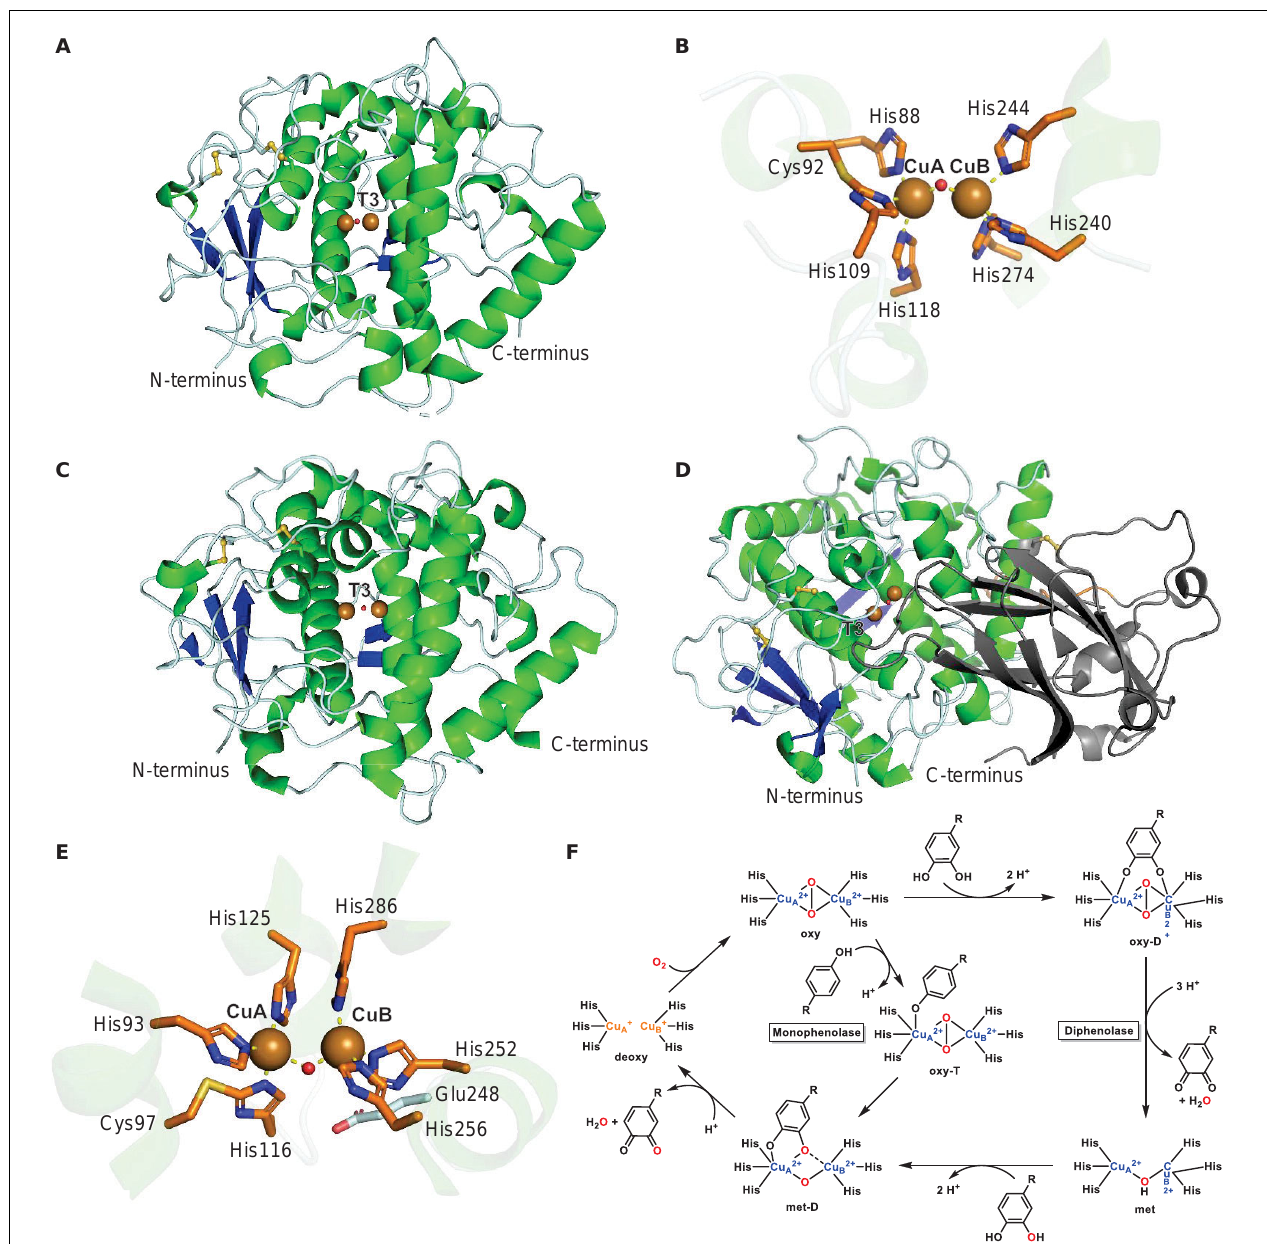
FIGURE 4 | Structures and mechanism of plant type III polyphenol oxidases. (A) Protein structure of active form of sweet potato catechol oxidase Ip CO (PDB: 1BT1) (Klabunde et al., 1998). (B) T3 copper center of sweet potato catechol oxidase Ip CO. (C) Protein structure of active walnut tyrosinase Jr TYR (PDB ID: 5CE9) (Bijelic et al., 2015). (D) Protein structure of latent aurone synthase Cg AUS (PDB: 4Z11) (Molitor et al., 2016). C-terminal shielding domain is highlighted in dark gray. (E) T3 copper center of walnut tyrosinase Jr TYR. (F) Catalytic mechanism of monophenolase reaction (inner cycle) and diphenolase reaction (outer cycle) in plant type III polyphenol oxidases. Adapted with permission from Solomon et al. (2014; Copyright 2014 American Chemical Society). In PPO protein structures, α -helices are highlighted in green, β -sheets in blue, disulfide bonds in yellow, copper atoms are brown spheres and water or hydroxides are red spheres. Copper coordination is highlighted in copper center figures by yellow dashed